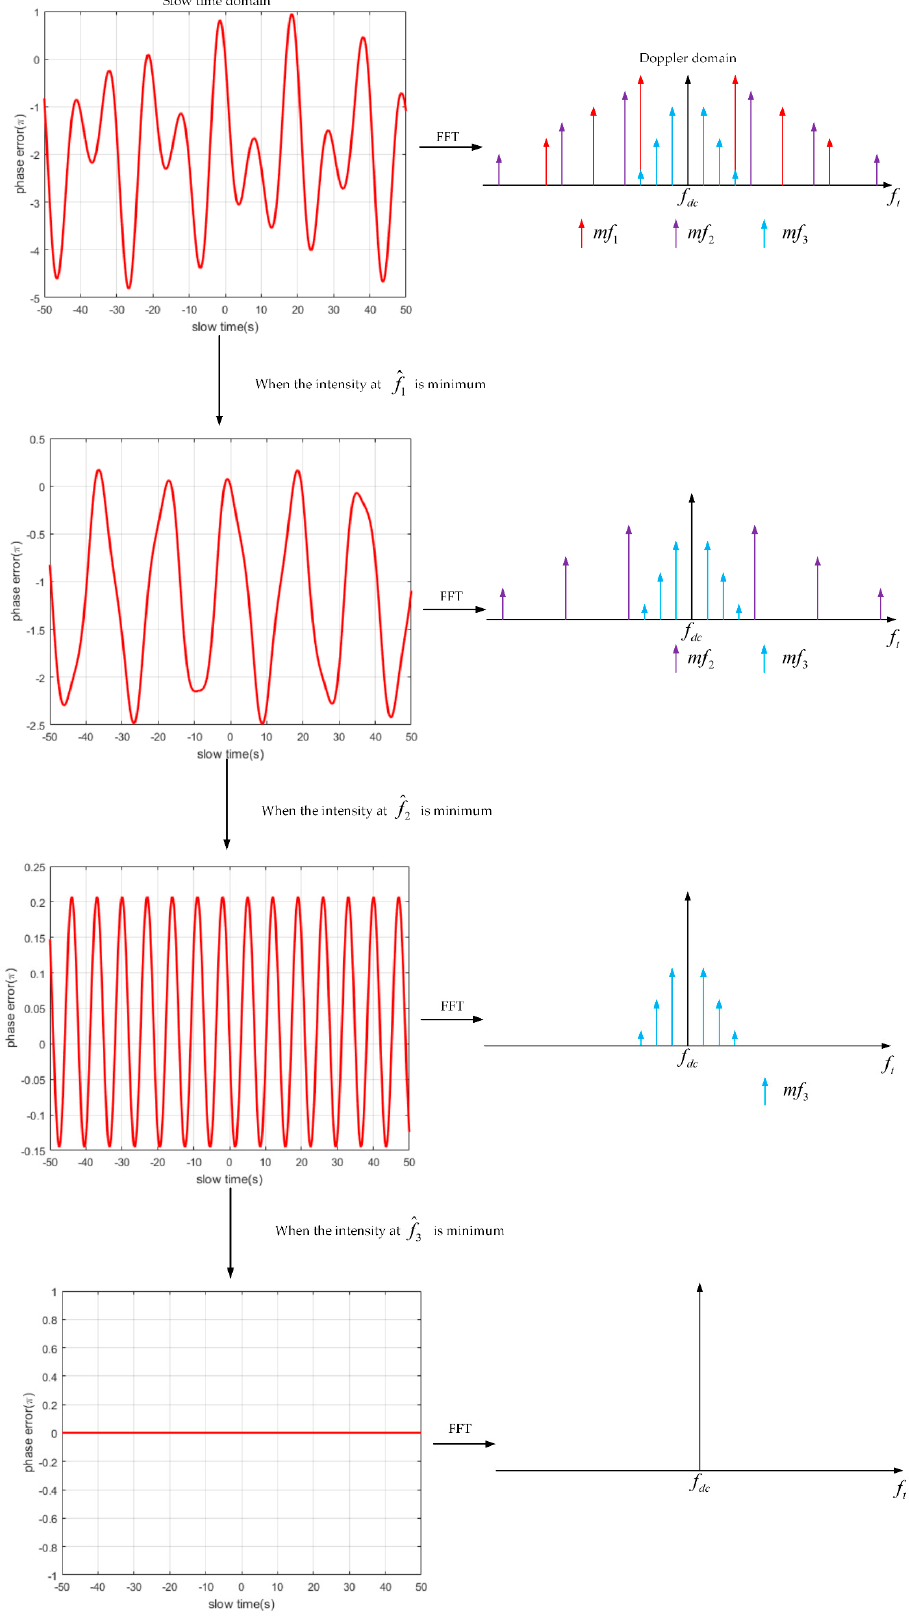
Figure 5. Compensation for the influence of each sinusoidal function separately. Based on (34), searching parameters and phase compensation with searching values for each sinusoidal function in a range cell are shown in Figure 5. Firstly, the 1st sinusoidal function of (32) is ˆ f is minimal, the influence of and ϕ . When the intensity at compensated for by searching Θ ,1 i 1 1 the 1st sinusoidal function is compensated for and the searching values of the amplitude and initial ˆ ˆ , respectively. Then, the 2nd and 3rd sinusoidal and ϕ phase are the matched values of Θ ,1 i 1 functions are compensated for with the same method. The compensation function for the influence of the sinusoidal function can be expressed as ( )